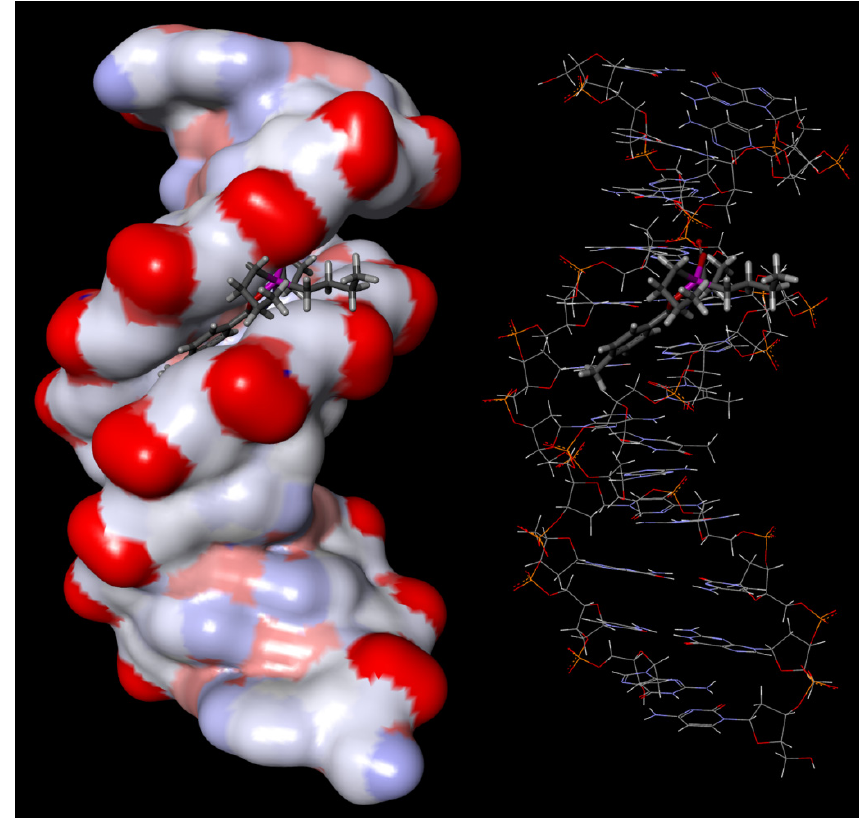
Figure 8. Molecular modeling of the interaction between 4b and DNA.